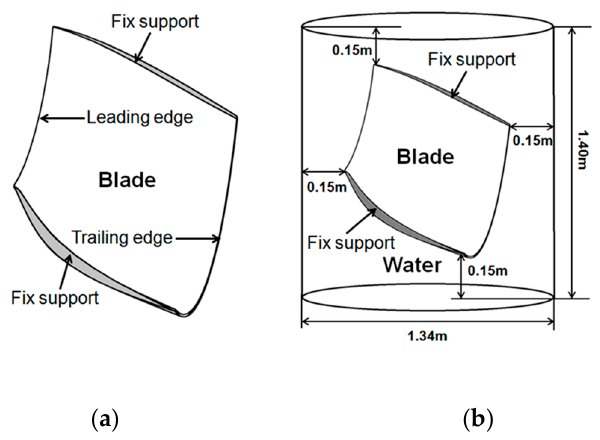
Figure 5. ( a ) Geometry and boundary conditions of a single blade in air; ( b ) geometry and dimensions of the surrounding cylindrical water domain.